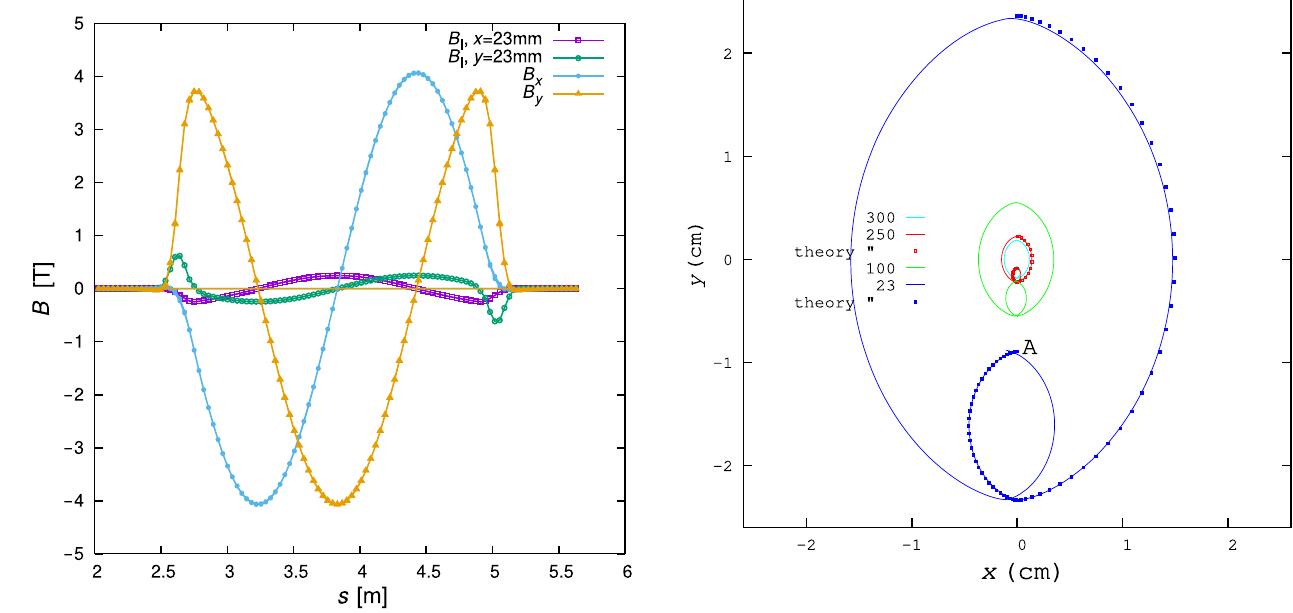
FIG. 7. Transverse projection of the helical motion across FIG. 6. Field along the helical trajectory arc across a R þ snake an R þ R − R þ R − snake series, using OPERA field maps. A ¼ 322 A, B ¼ helix (using its OPERA field map, current I smaller excursion is in the outer, low-field helices. Solid lines are 0 in 4 . 07 T positive, k > 0 ). Two cases are displayed: x ¼ 23 mm or from motion integration through field maps, at 23 and 100 GeV 0 y ¼ 23 mm, all other coordinates are zero: the transverse field and, very close to each other, 250 and 300 GeV; markers at 23 and 0 components are verified to be essentially independent of x ð s Þ and 250 GeV are from theory [Eq. (5)]. RHIC closed orbit goes y ð s Þ : B ≈ − B ð ks Þ , B ≈ B ð ks Þ (Eq. (3), with yet a counterclockwise from the top of a smaller helix, “ A ” for instance x 0 sin y 0 cos at 23 noticeable effect of field falloffs at helix ends.